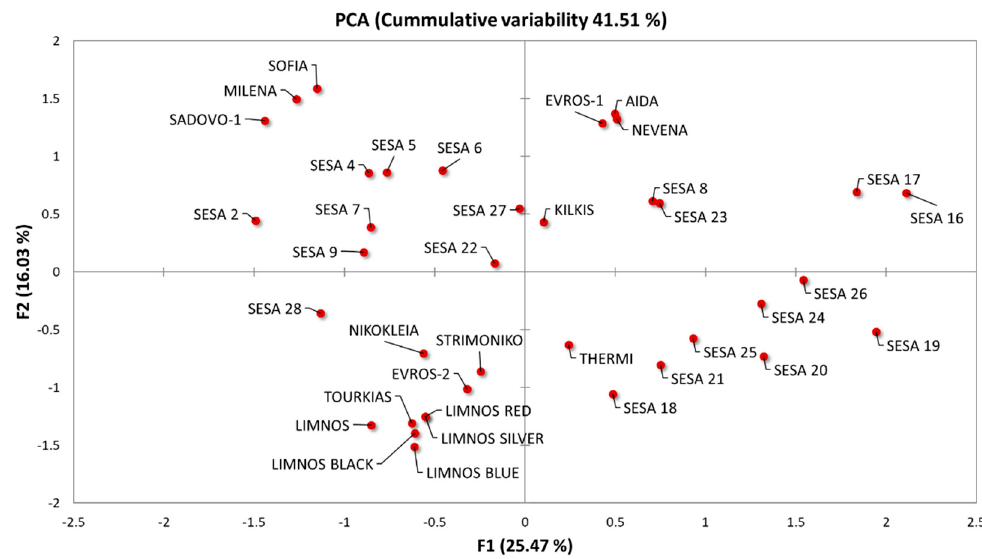
Figure 3. Principal component analysis (PCA) biplot based on the morpho-physiological parameters of the 37 sesame cultivars regarding the first two principal components (F1 and F2).